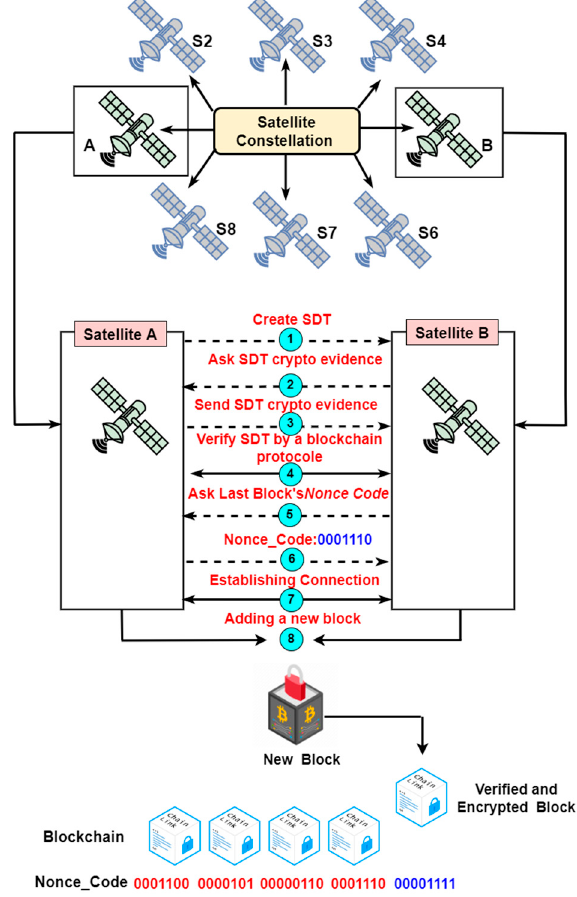
Figure 2. Proof of Space Transactions (PoST) protocol: Authenticating SDTs between two satellites within the same satellites constellation.